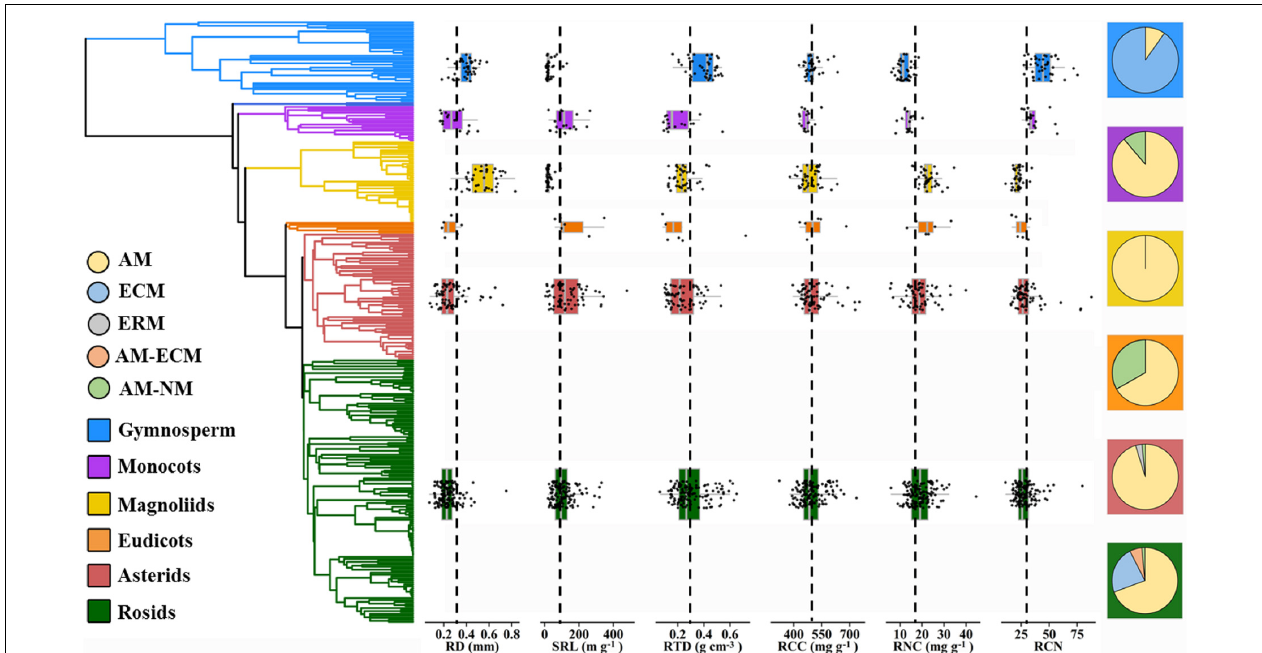
FIGURE 5 | Trait distribution for RD, SRL, RTD, RCC, RNC, RCN, and mycorrhizal association for six major phylogenetic clades (gymnosperms, monocots, magnoliids, basal eudicots, asterids, and rosids). Basal eudicots include species that are not included in the clades of rosids and asterids. Chloranthales is not included because the species number is small ( n = 2). The left indicates the phylogenetic tree of 306 species. Dashed line along the box graphs (middle) represents the arithmetic mean of each root trait. Pie charts (right) indicate the proportion of each mycorrhizal type in each phylogenetic clade. RD, root diameter; SRL, specific root length; RTD, root tissue density; RCC, root C content; RNC, root N content; RCN, root C:N ratio; AM, arbuscular mycorrhizal; ECM, ectomycorrhizal; ERM, ericoid mycorrhizal; NM,